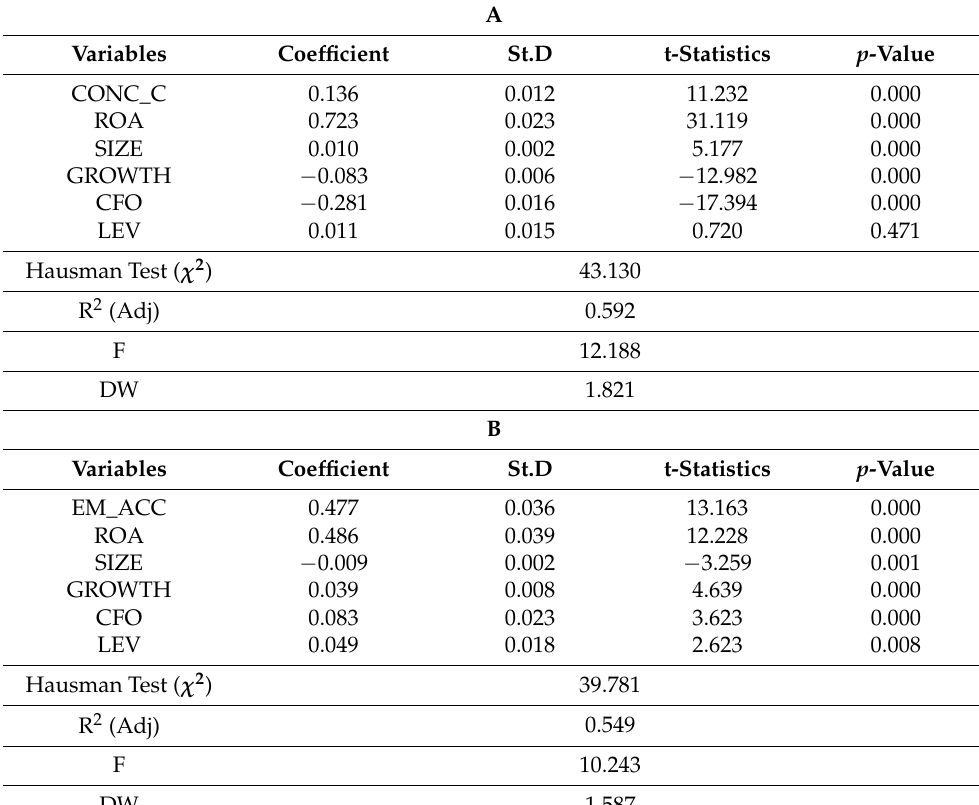
Table 9. Panel A: Empirical results of simultaneous equations between accounting conservatism and earnings management ( EM_ACC is the dependent variable, 2SLS test). Panel B: Empirical results of simultaneous equations between accounting conservatism and earnings management ( CONC_C is the dependent variable, 2SLS